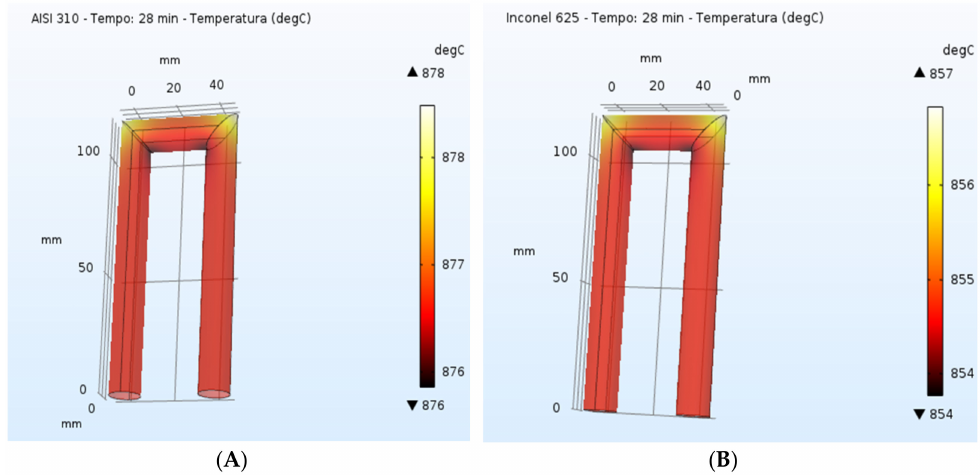
Figure 10. Temperature profiles in the internal tube. ( A ) AISI 310, ( B ) Inconel 625.